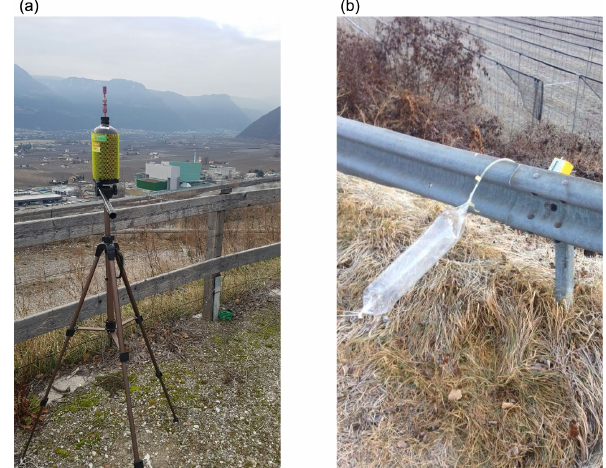
Figure 2. Vacuum-filled glass bottle (a) and polyvinyl fluoride (PVF) bag (b) used to collect samples of ambient air. These pic- tures were taken during the tracer releases of BTEX. On the right of the vacuum bottle, the incinerator of Bolzano can be